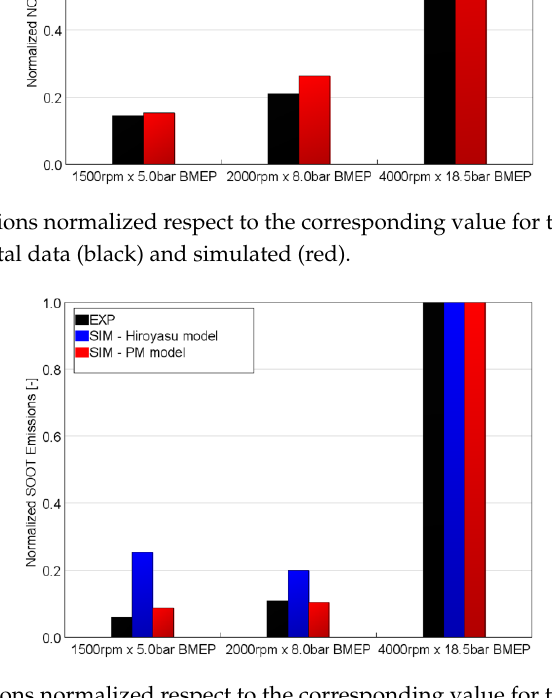
Figure 13. Soot emissions normalized respect to the corresponding value for the 4000 rpm × 18.5 bar BMEP WP. Experiments (black) compared with numerical results obtained by means of the Hiroyasu empirical model (blue) and detailed PM model (red).